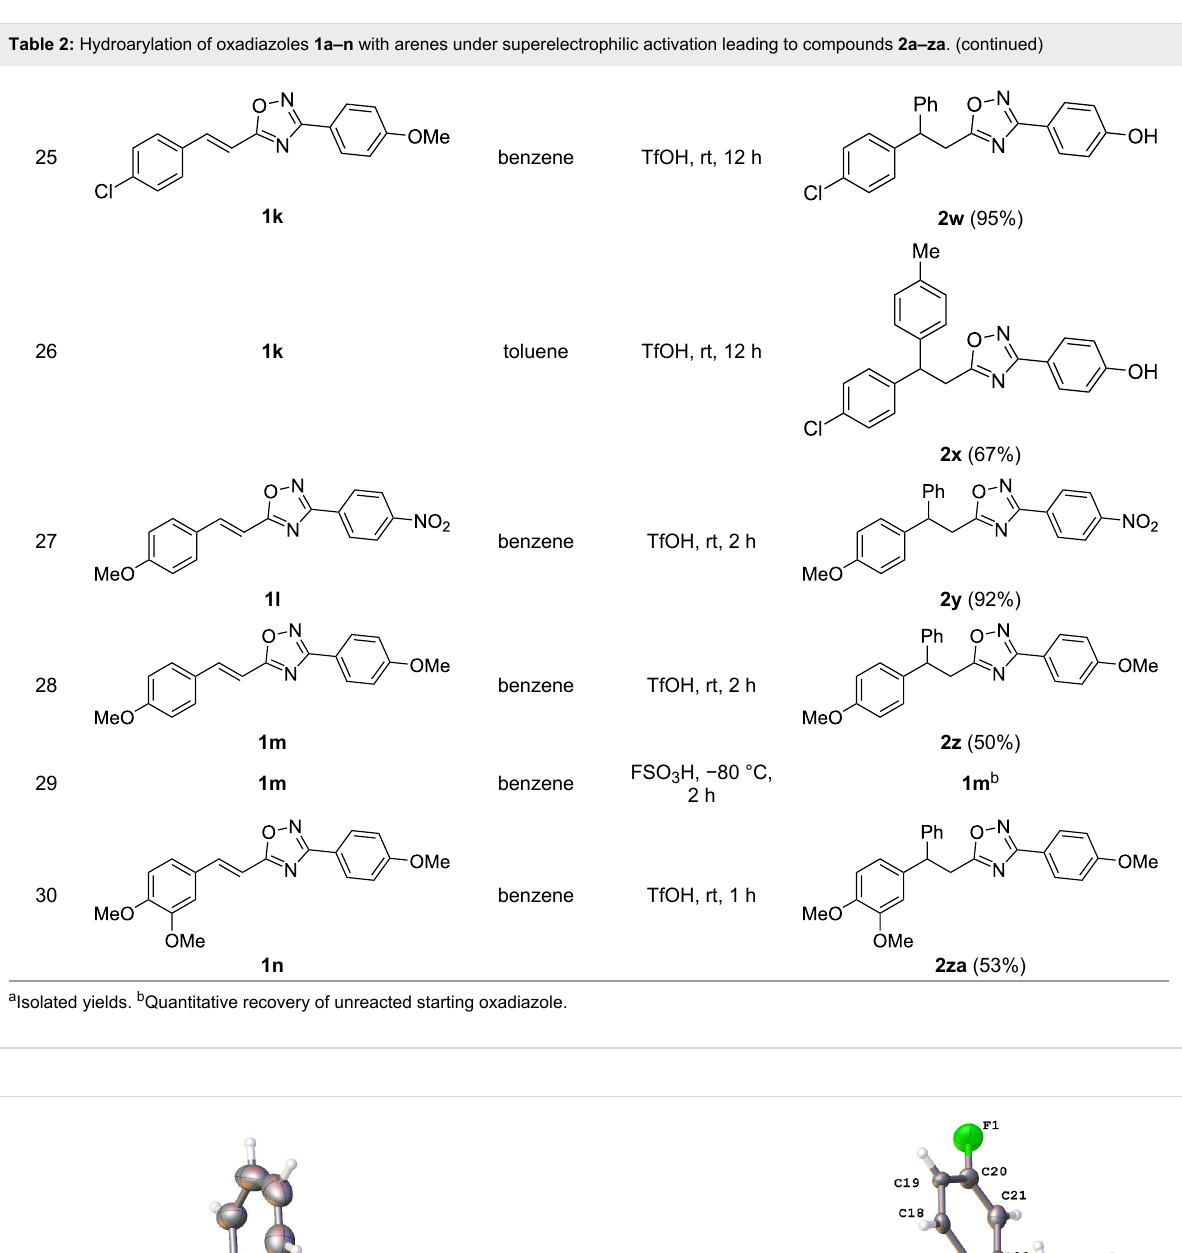
double bond, resulting in a reduced reaction time to 1–2 h at room temperature (Table 2, entries 13, 16, 27, 28, and